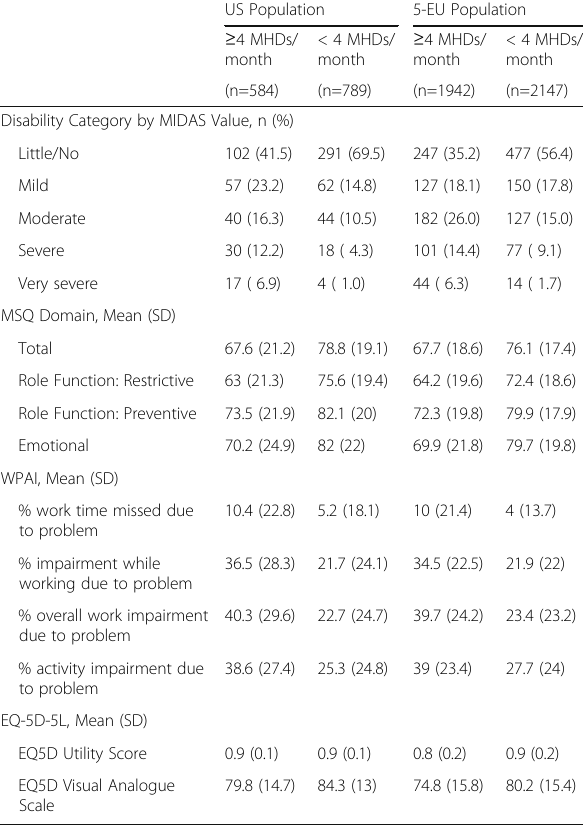
Table 1 (abstract P96). Patient ‑ reported outcome (PRO) measures in patients with migraine who experience ≥ 4 migraine headache days/ month and <4 migraine headache days/month in the US and in five European countries US